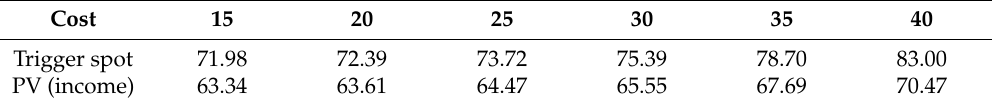
Table 2. Trigger spot price of the investment option for different unit costs ($/bbl).